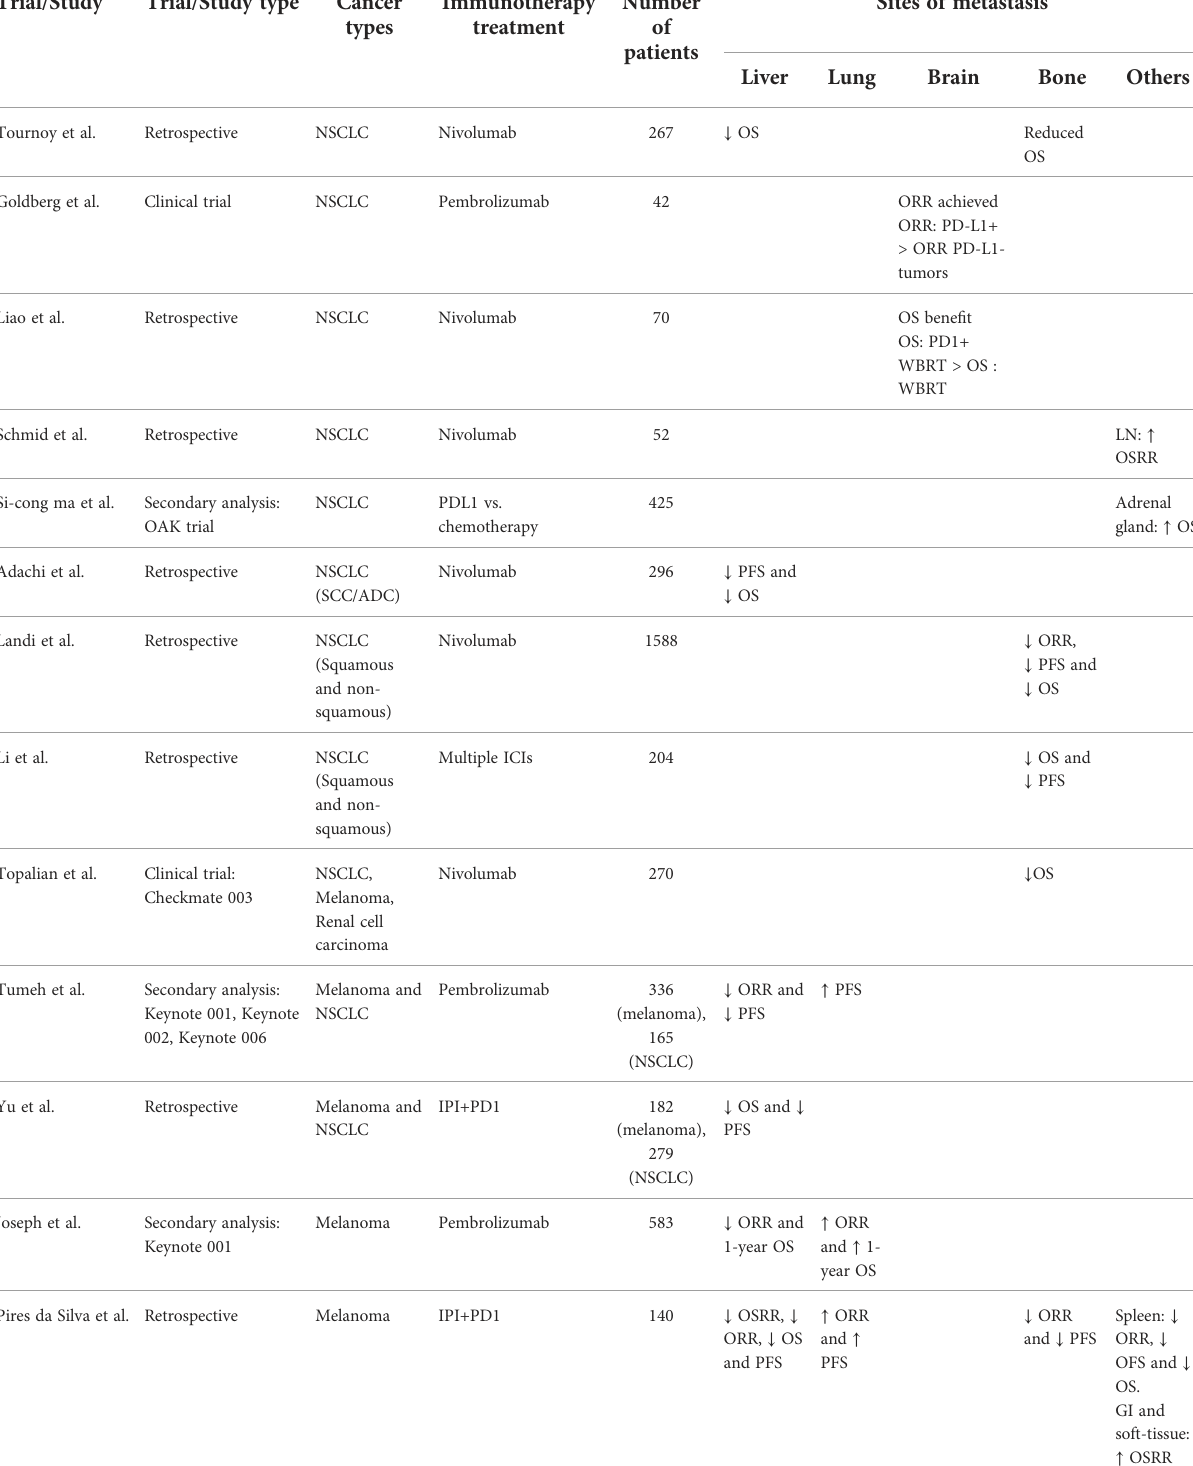
TABLE 1 Summary of the organ speci fi c response and survival rates from highlighted clinical studies.